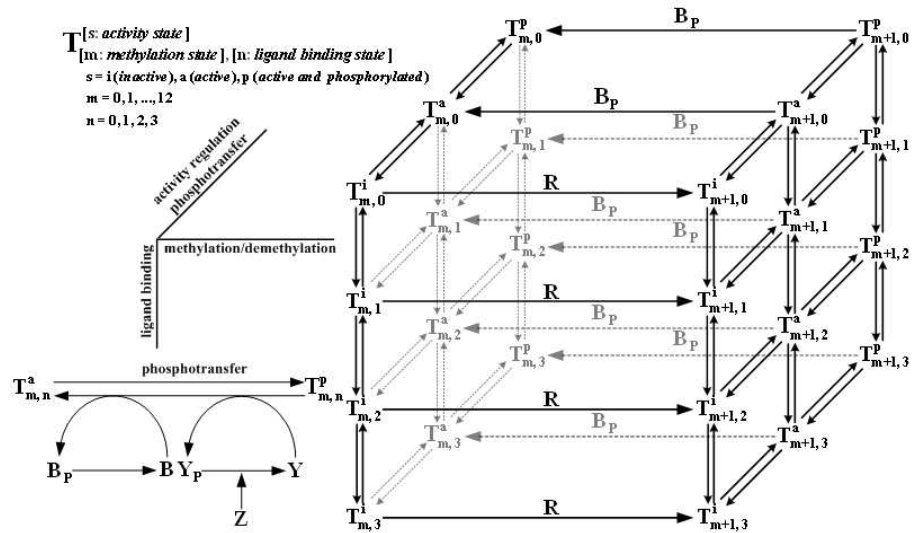
Figure 6. Signal transduction network. The basic unit of the network is the signaling complex, denoted by T. The three indices used to denote the properties of the complex are shown in the upper left corner. In the reaction network, vertical transitions are ligand binding and release, horizontal transitions are methylation and demethylation, and front-to-rear and reverse transitions are kinase activation, deactivation, phosphorylation and dephosphorylation. The details of the phosphotransfer transitions are depicted at the left. Adopted with permission from